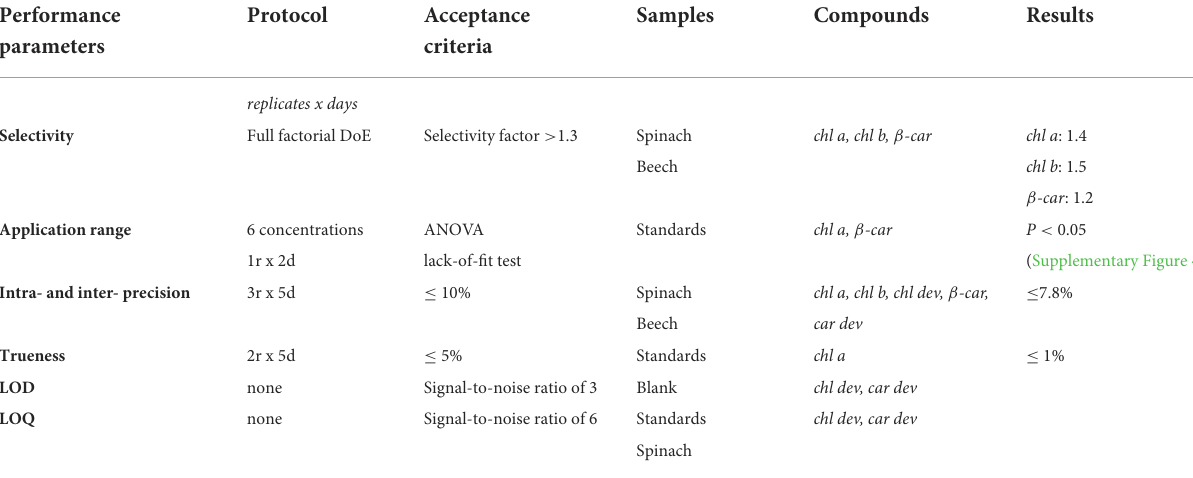
TABLE 1 Tested performance parameters of the chromatographic separation.